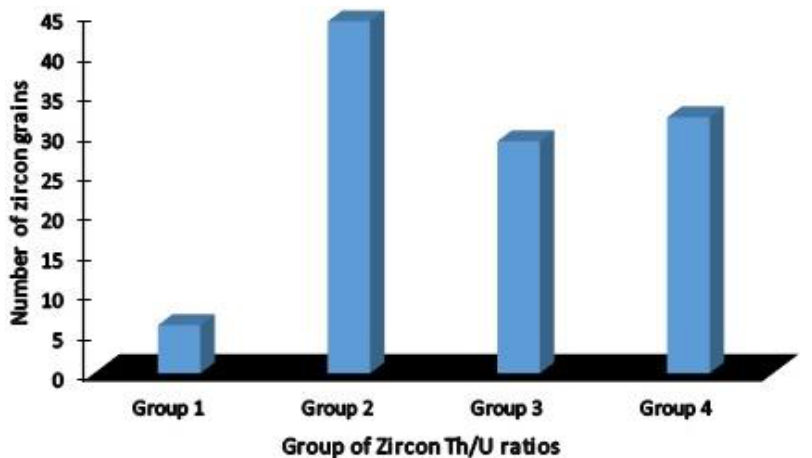
Figure 3. Number of zircon grains in various classified Th/U ratio’s groups (group 1: Th/U < 0.2, group 2: Th/U [0.2–0.5], group 3: Th/U [0.5–1.0], and group 4: Th/U > 1.0).